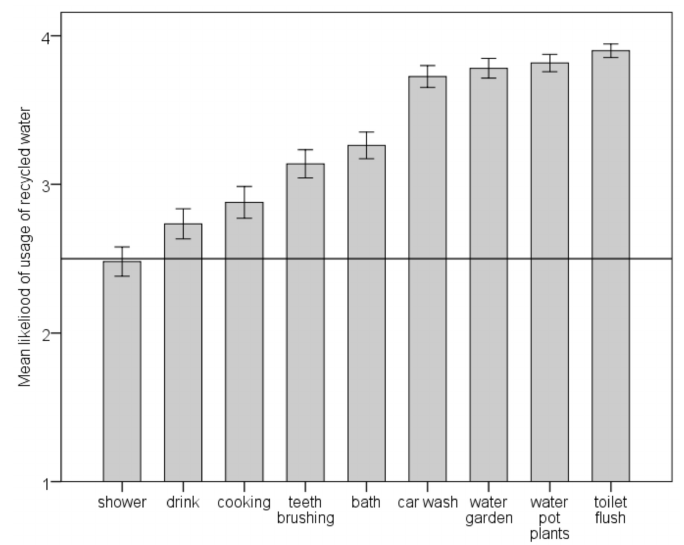
Figure 2. Q3: “Would you use tap water recycled from wastewater by the most modern technology for ... ”. Line represents the mean of rating options (2.5). Error bars (95%